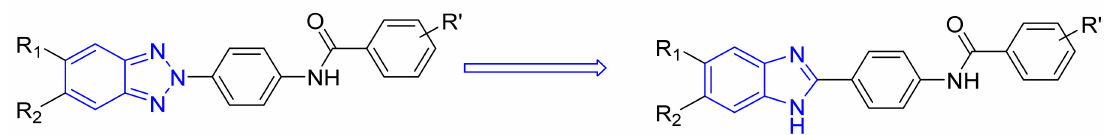
Figure 1. Isosteric substitution of benzotriazole scaffold with benzimidazole